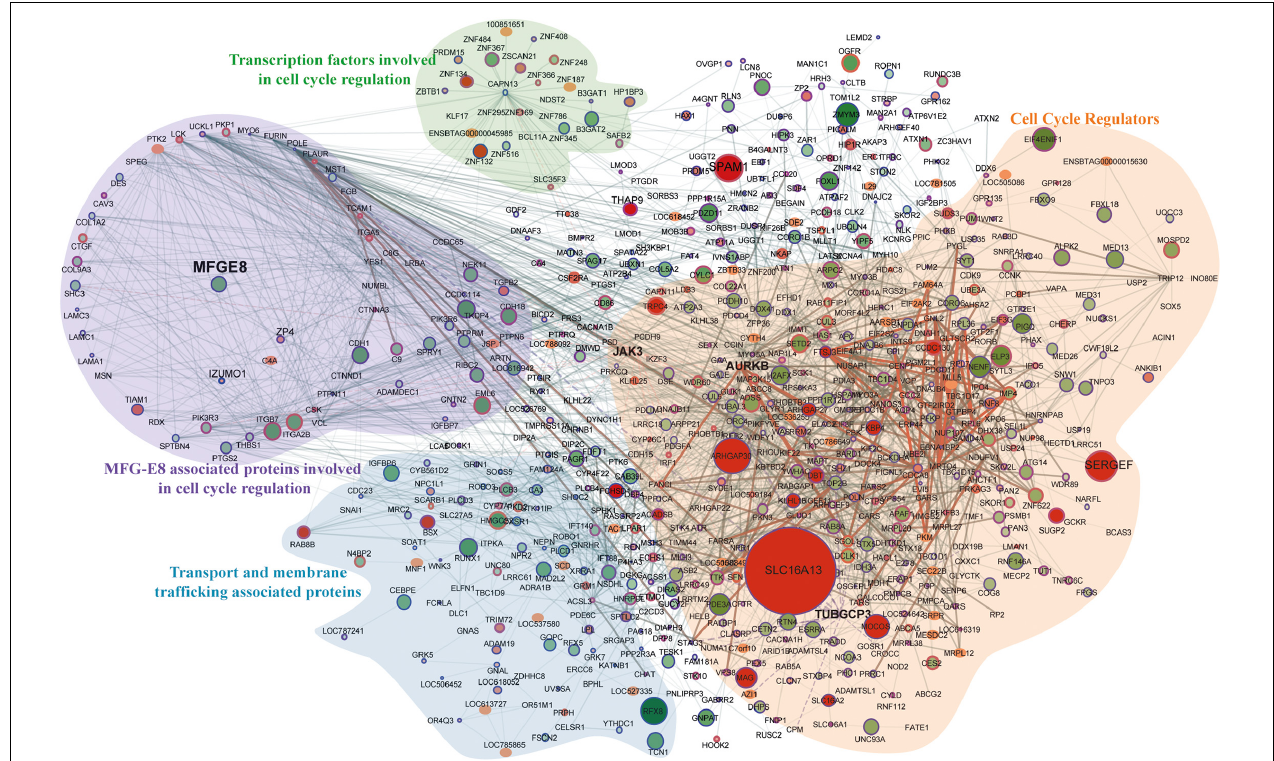
FIGURE 5 | Protein-protein interaction map for top significantly ( p -value < 0.001) expressed proteins. The total number of nodes is 682 with 2140 interacting edges, node color and size both show the up/downregulation, specifically, darker color and bigger size node defines the high value of the fold change. The smaller size node defines no observed fold change in proteomics data. The border of the nodes shows the significance of the lesser p -values < 0.001; thicker the border lowest is the assigned p -values. The thickness of the edges describes the experimentally identified co-expressed proteins in the